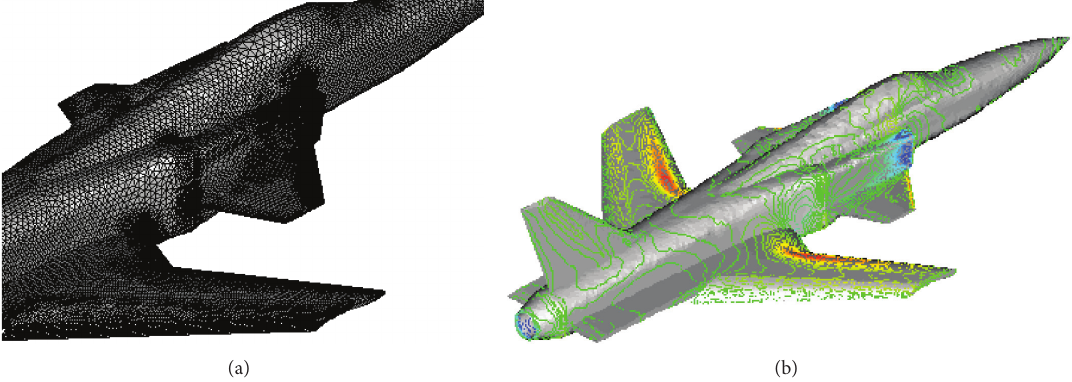
(a) (b) F 8: X29 aircra. �oom over part of the re�nement and Mach number distribution on the body for the grid . ℳ 1 T 3: X29 aircra. Comparison among different preconditioners T 1: X29 aircra. Time for successive adaptations using 8 and